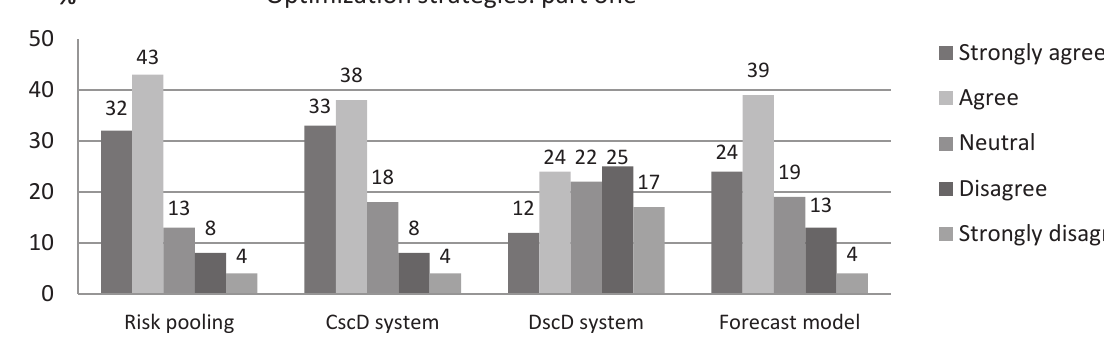
Figure 1. Global optimization strategies on bullwhip effect – part one